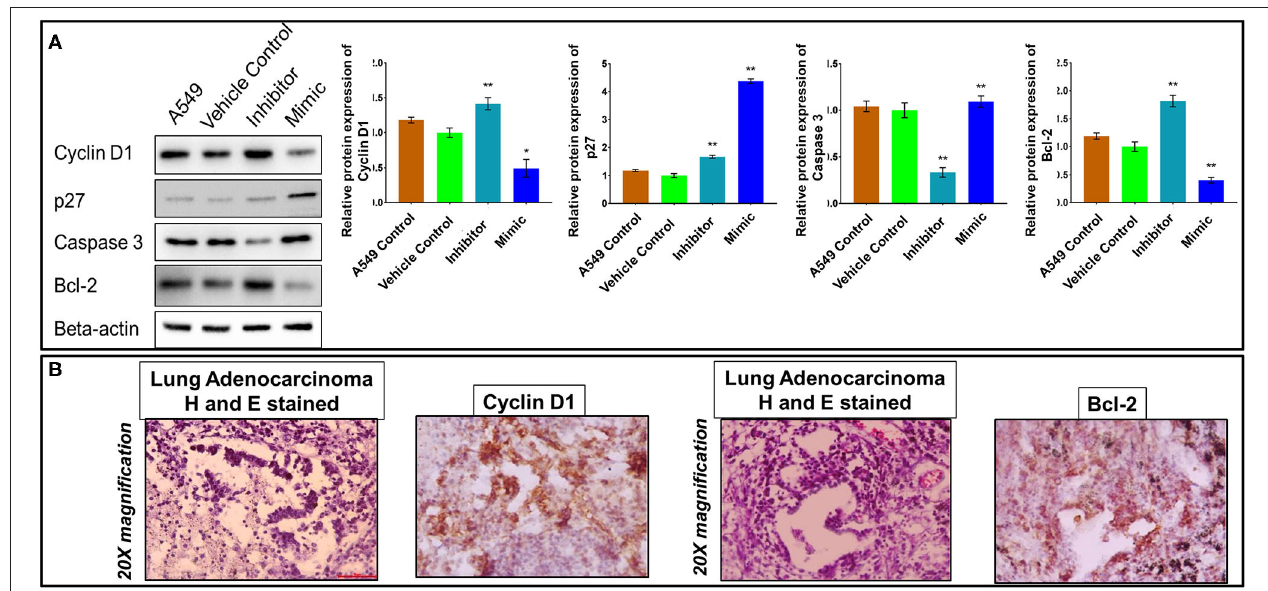
FIGURE 4 | MiR-320a affects cell cycle progression and apoptosis in A549 cells. (A) Immunoblot assays (a representative blot is shown) were used to determine normalized protein levels of Cyclin D1, p27, Caspase 3, and Bcl-2 in untransfected A549 cells, A549 cells transfected with vehicle control, a miR-320a inhibitor (100nM), or a mimic (100nM). All experiments were carried out three independent times. The data are presented as mean ± SEM where * p > 0.05, ** p < 0.05 significant differences from vehicle control calculated using paired t -test. (B) Immunohistochemistry images represent tumor cells positive (brown-stained) for Cyclin